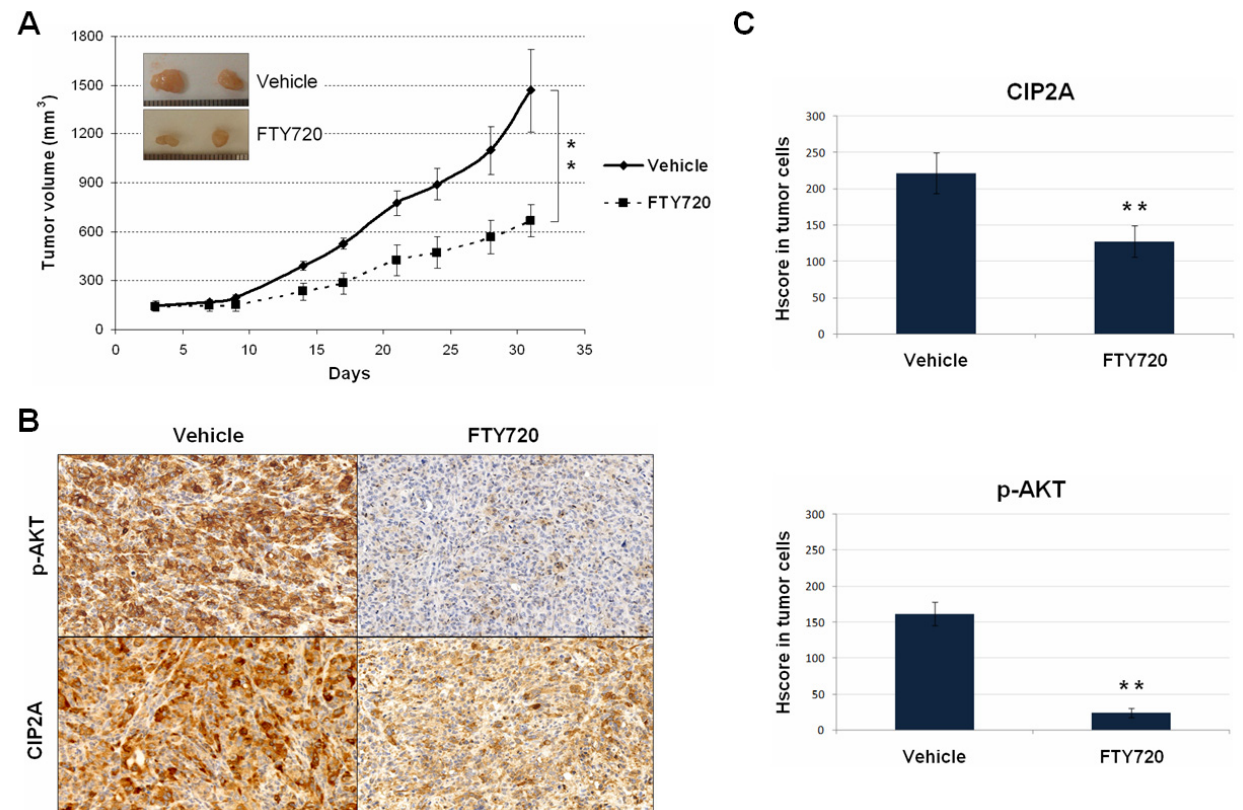
Figure 3. In vivoanalysis of FTY720-mediated CIP2A/AKT inhibition: ( A ) Tumor growth; ( B ) Immunohistochemical detection of p-AKT and CIP2A in tumor samples from control and treated groups. ( C ) Evaluation of differential expression of CIP2A and p-AKT. ** p < 0.001.